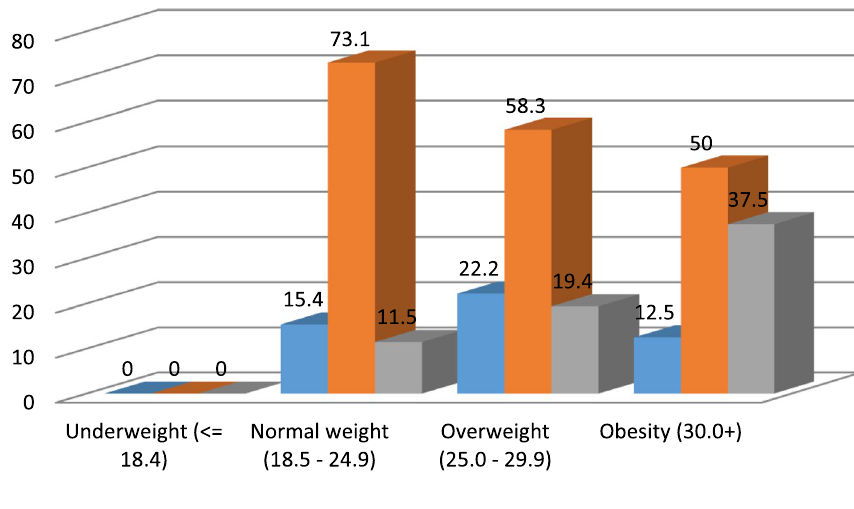
Fig. 1 Bar chart of relationship of BMI with physical activity